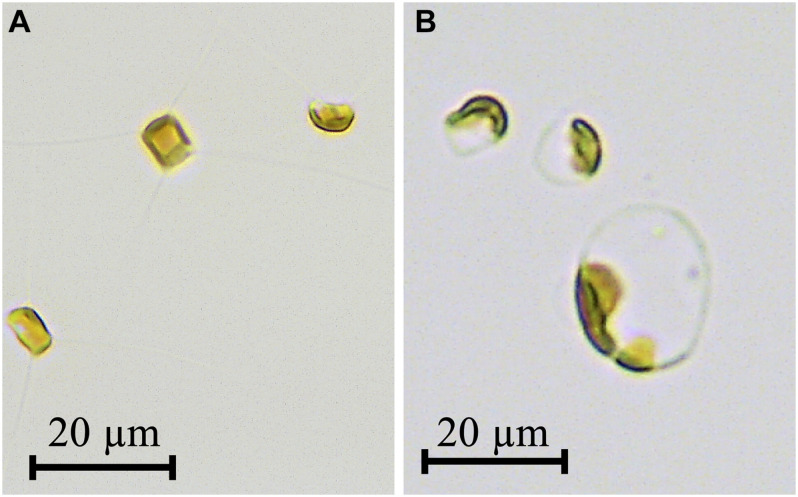
Photomicrographs of Chaetoceros gracilis grown at dilution rate of 0.2 d–1 under 300 μmol m–2 s–1
(A) and dilution rate of 0.2 d–1 under 1,000 μmol m–2 s–1
(B). Scale bar = 20 μm.